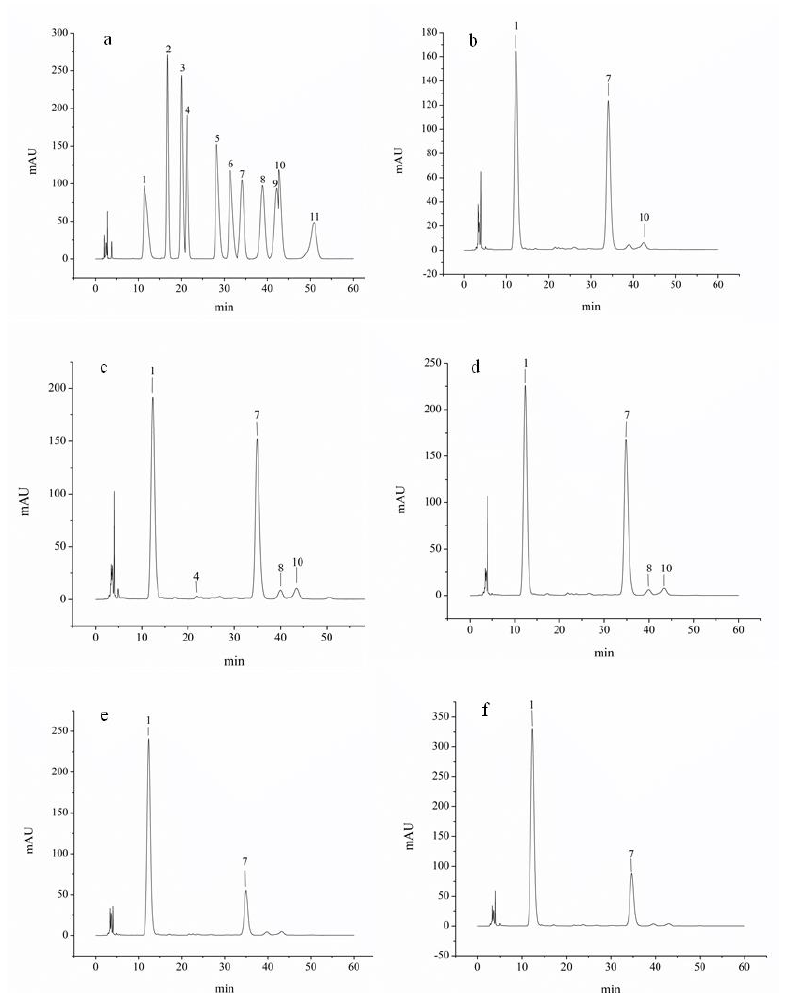
Figure 1. HPLC chromatogram of standard monosaccharide and QPs ( a ) standard monosaccharide, ( b ) QPE50, ( c ) QPE60, ( d ) QPE70, ( e ) QPE80, ( f ) QPE90 (1. PMP, 2. Mannose, 3. Ribose, 4. Rhamnose, 5. Glucuronic acid, 6. Galacturonic acid, 7. Glucose, 8. Galactose, 9. Xylose, 10. Arabinose, 11. Fucose).